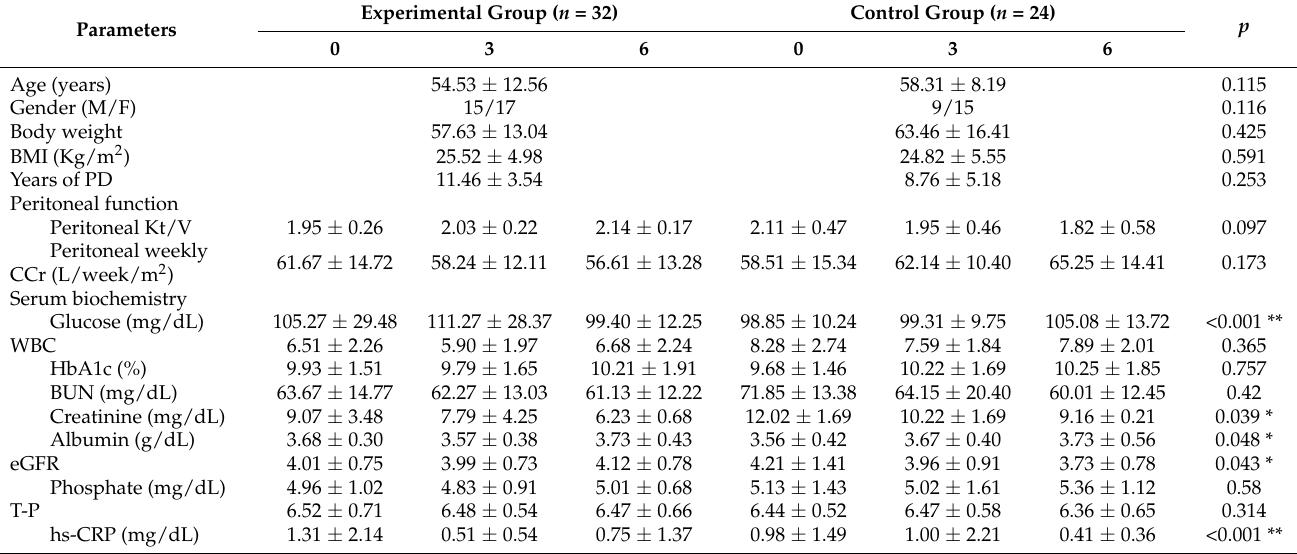
Table 2. Baseline demographic and clinical parameters of the experimental group (FIR) and control group (non-FIR).